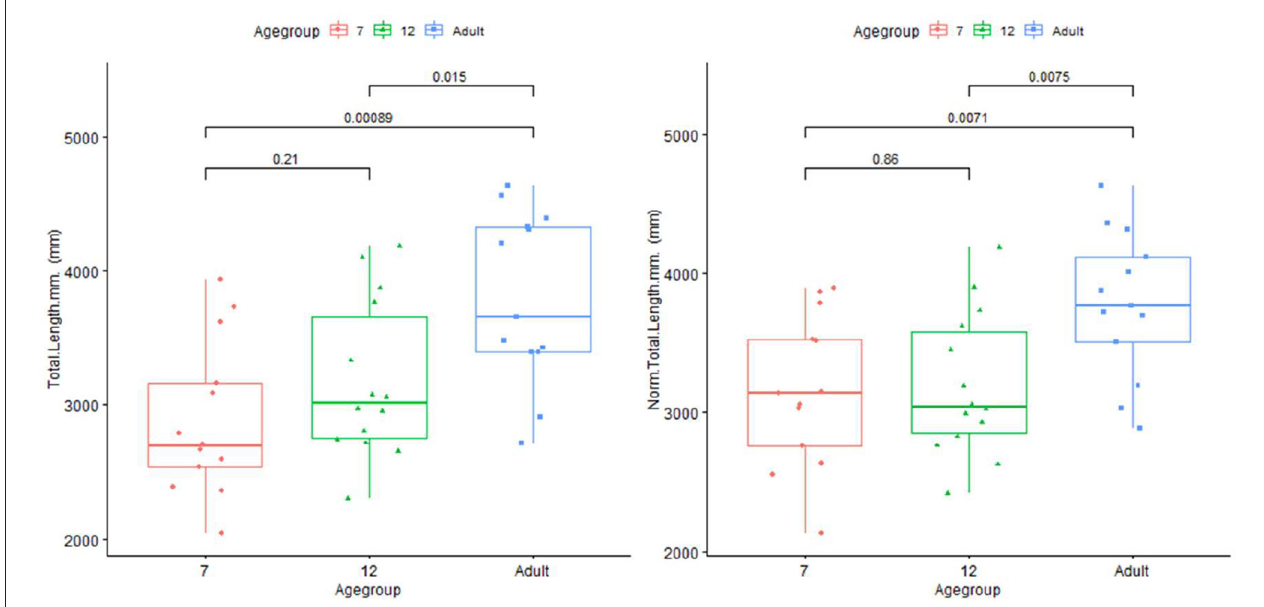
FIGURE 4 | Plot for length and normalized length in infants (age group in months) and adults.